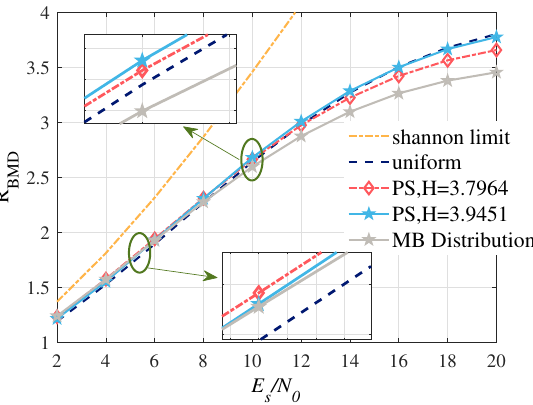
Figure 5. R BMD for PS-16QAM over the Gamma-Gamma channel with fixed entropy for each